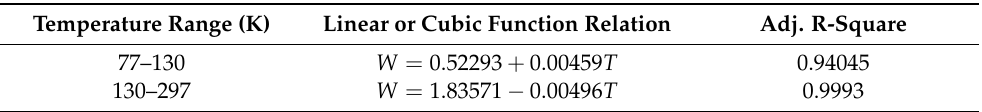
Table 1. Temperature dependence of the integrated SSE and BEE PL peak area ratio of the